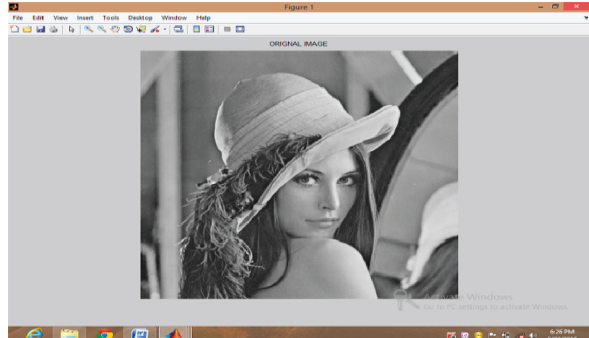
Figure 19: Original image of Lena.